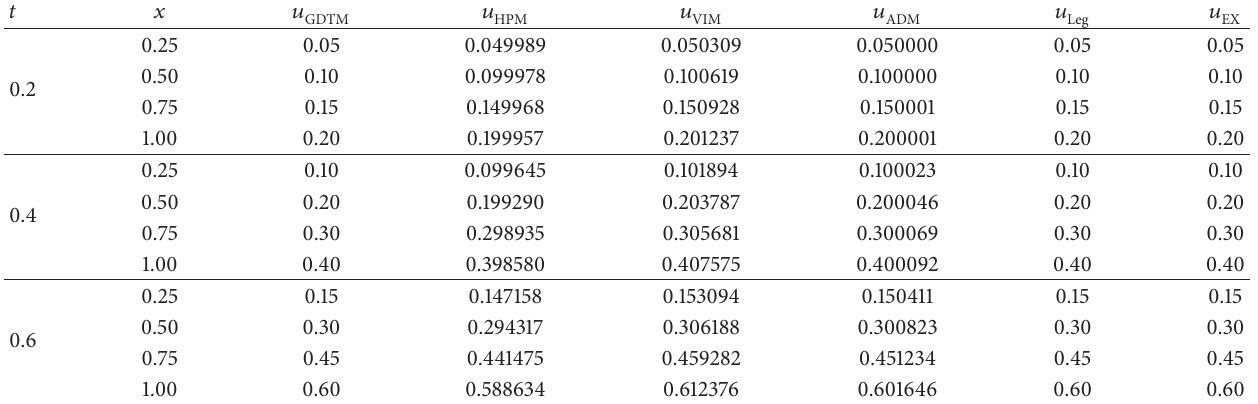
Table 5: Numerical values when 𝛼 = 1 .